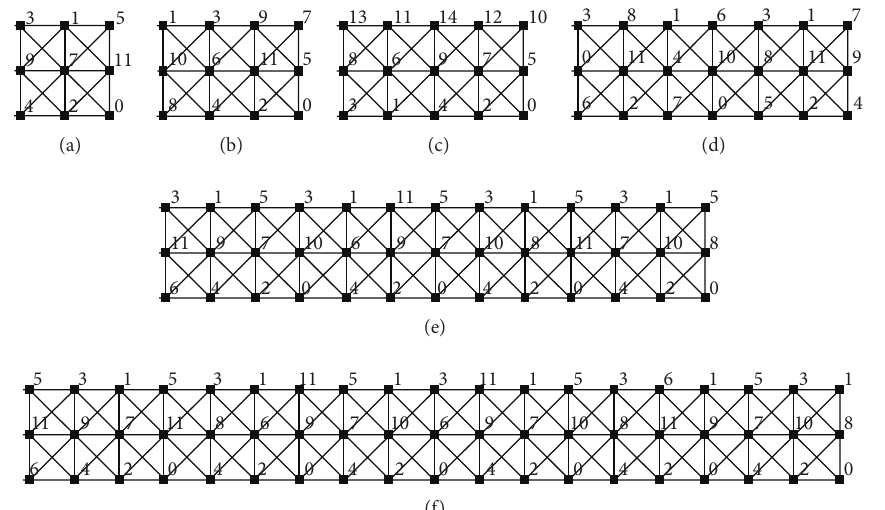
Figure 8: (a) 11 - 𝐿(2, 1) -labeling of 𝑃 3 ⊠ 𝐶 3 , (b) 11 - 𝐿(2, 1) -labeling of 𝑃 3 ⊠ 𝐶 4 , (c) 14 - 𝐿(2, 1) -labeling of 𝑃 3 ⊠ 𝐶 5 , (d) 11 - 𝐿(2,1) -labeling of 𝑃